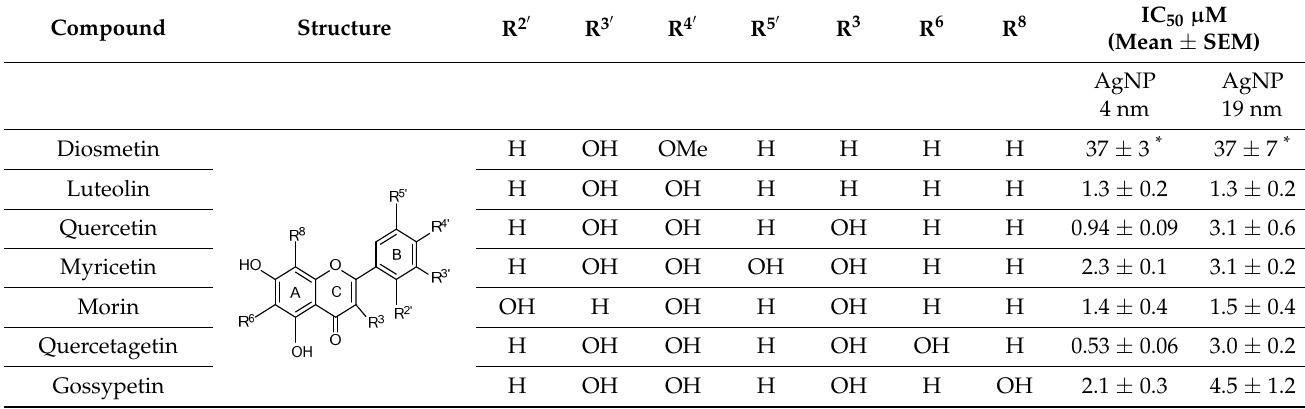
* Percentage of inhibition at the highest tested concentration, 25